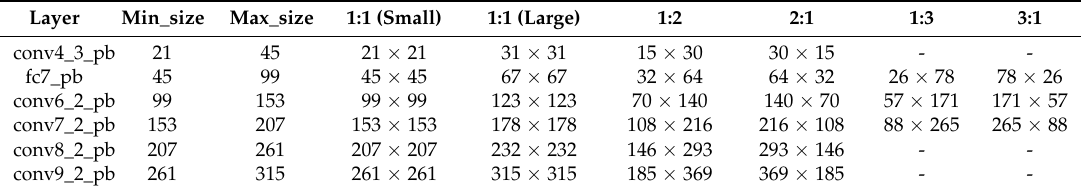
Table 2. The learned average default box size for each feature map cell in different concatenated feature layers using the extend VGGNet (300 × 300 input).